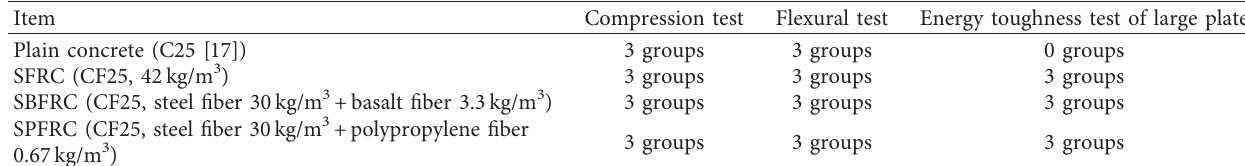
Table 1: Test grouping.